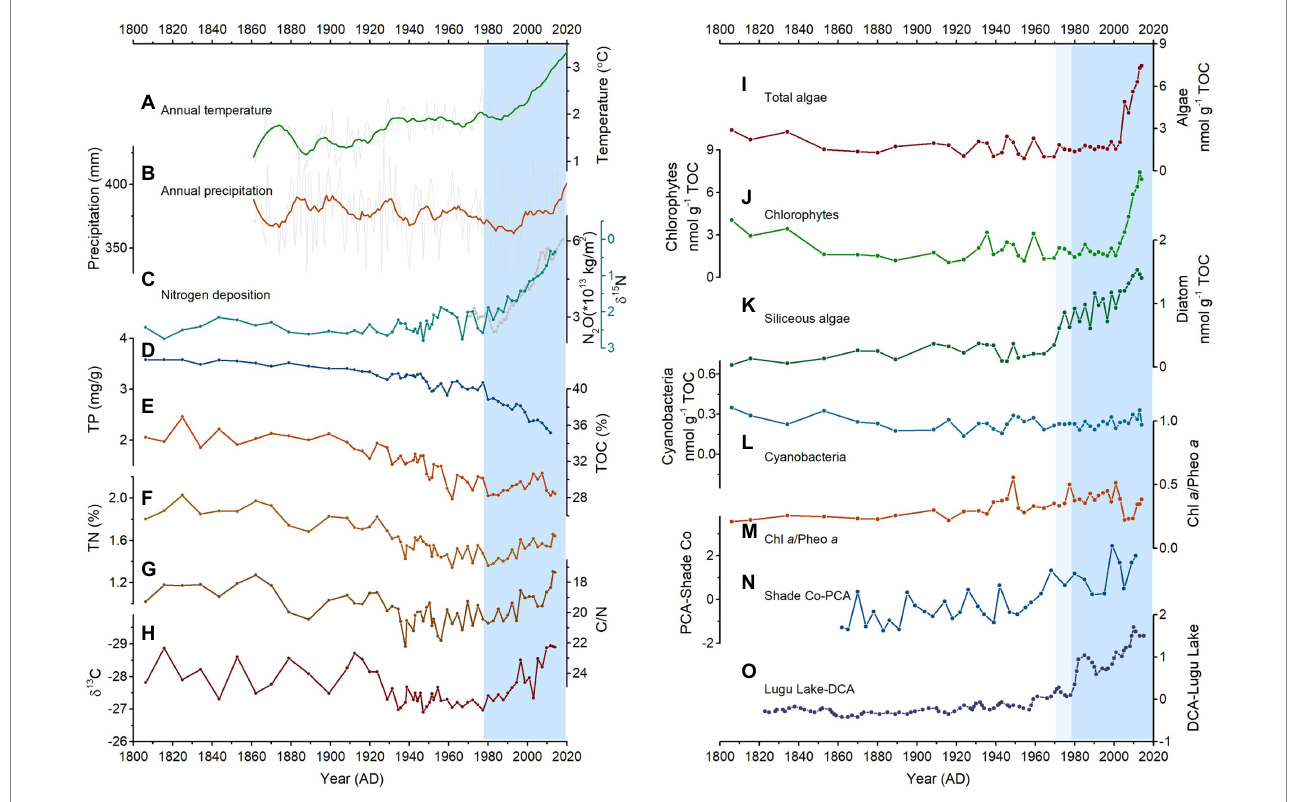
FIGURE 3 Historical environmental and ecological changes around the CQ Lake. (A) temperature and (B) precipitation changes, (C) sedimentary δ 15 N and N 2 O emission in the study region, (D) the concentration of sediment TP (Chai et al., 2018), (E) %TOC (Chai et al., 2018), (F) %TN (Chai et al., 2018), (G) the ratio of C/N (Chai et al., 2018), (H) δ 13 C; The biomass of different algae (average concentration from sediment pigments) including (I) total algae (Chl α and pheophytin α ), (J) chlorophytes (Chl b , lutein, and pheophytin b), (K) siliceous algae (diatoxanthin), (L) cyanobacteria (canthaxanthin); (M) The ratio of Chl α / Pheo α , (N) pigment-based PCA at the Shade Co, and (O) diatom-based DCA at the Lugu Lake.